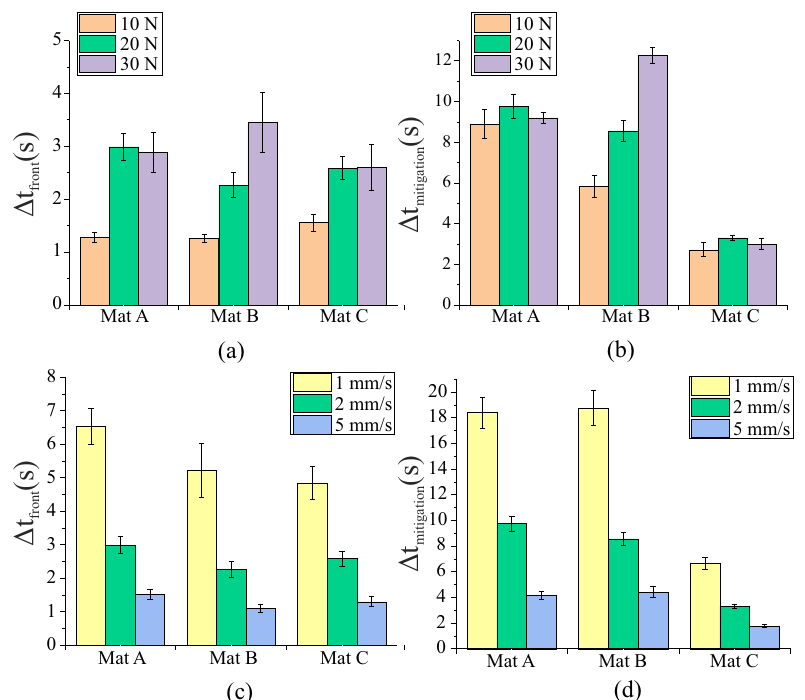
Figure 6. Graphs showing the mean time difference (N = 5) between ( a ) detection of slip at the outer and middle grasper islands ( ∆ t front ) for a variation in the force and material stiffness with a 2 mm/s retraction speed, ( b ) available mitigation time ( ∆ t mitigation ) for a variation in the force and material stiffness with a 2 mm/s retraction speed, ( c ) ∆ t front for a variation in the retraction speed and material stiffness with a 20 N clamp load, and ( d ) ∆ t mitigation for variations in the retraction speed and material stiffness with a 20 N clamp load. The error bars indicate the standard